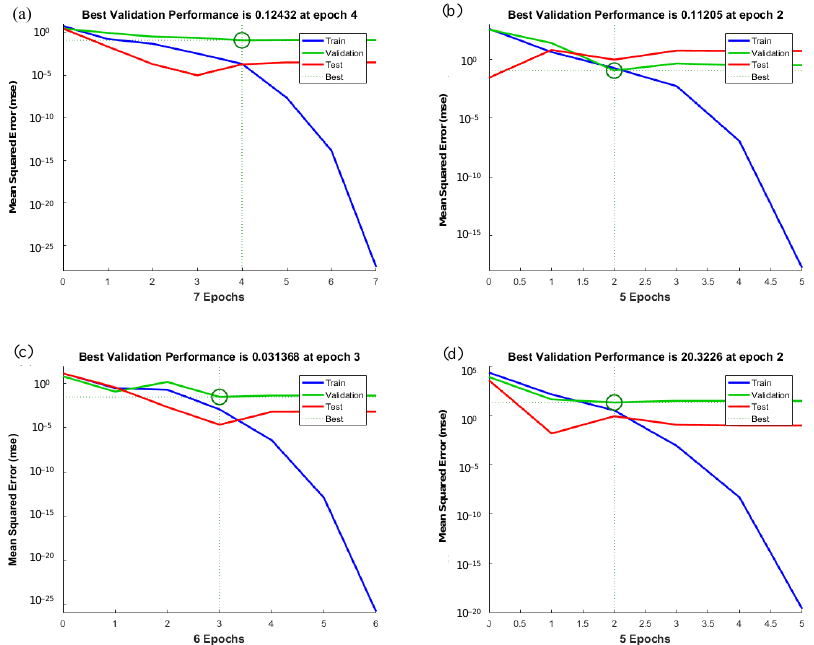
Figure 12. Training state in ANN models for prediction of ( a ) Id 2 , ( b ) SRH, ( c ) UPV, and ( d ) UCS.